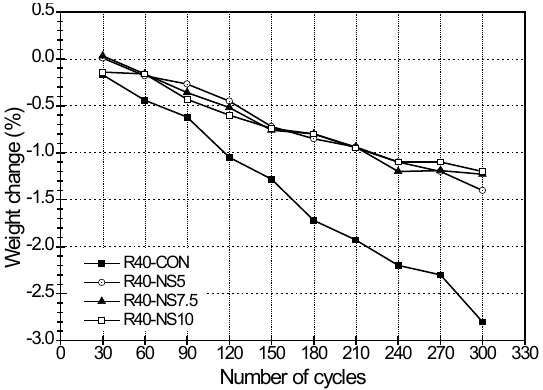
Figure 5. Weight change by freezing-thawing cycles.